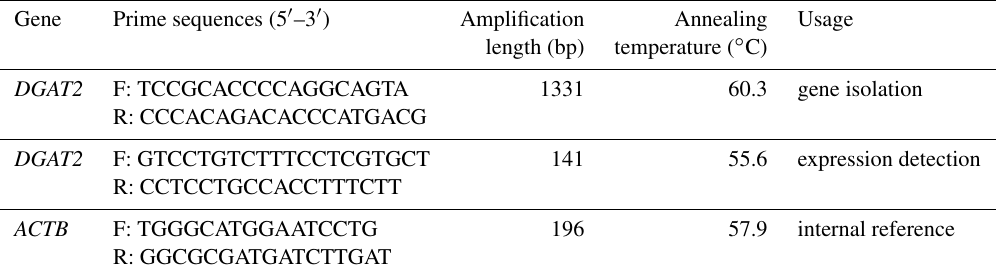
Table 1. Primers used for DGAT2 isolation and RT-qPCR. Gene Prime sequences (5 (cid:48) –3 (cid:48) )